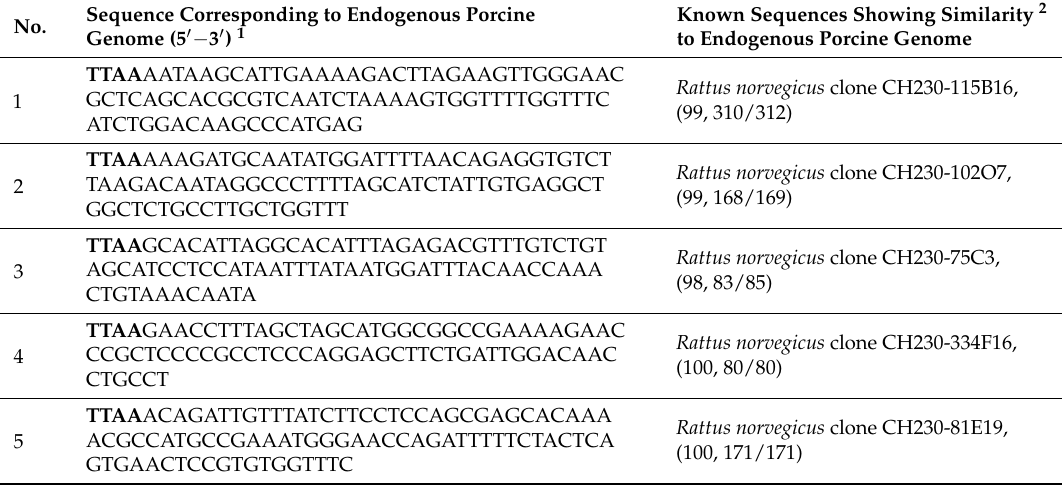
Table 3. Splinkerette PCR analysis results indicating PB -mediated integration sites in the porcine